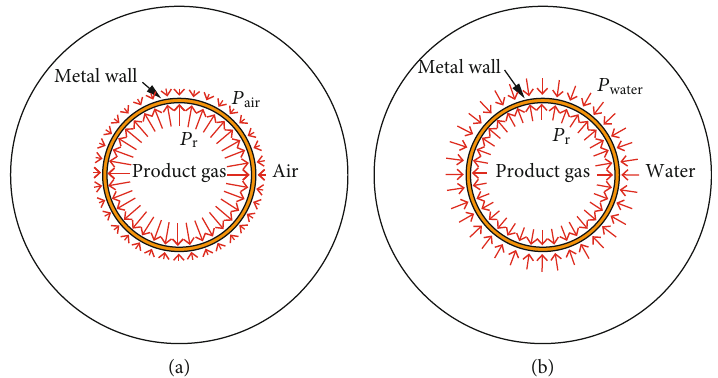
Figure 13: The schematic diagram on the resultant force applied on the cylinder wall at the second stage: (a) in air medium and (b) in water medium.